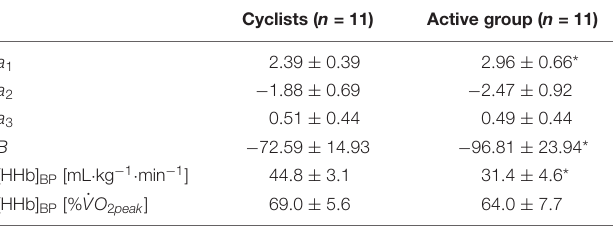
TABLE 3 | Muscle deoxygenation kinetics parameters.